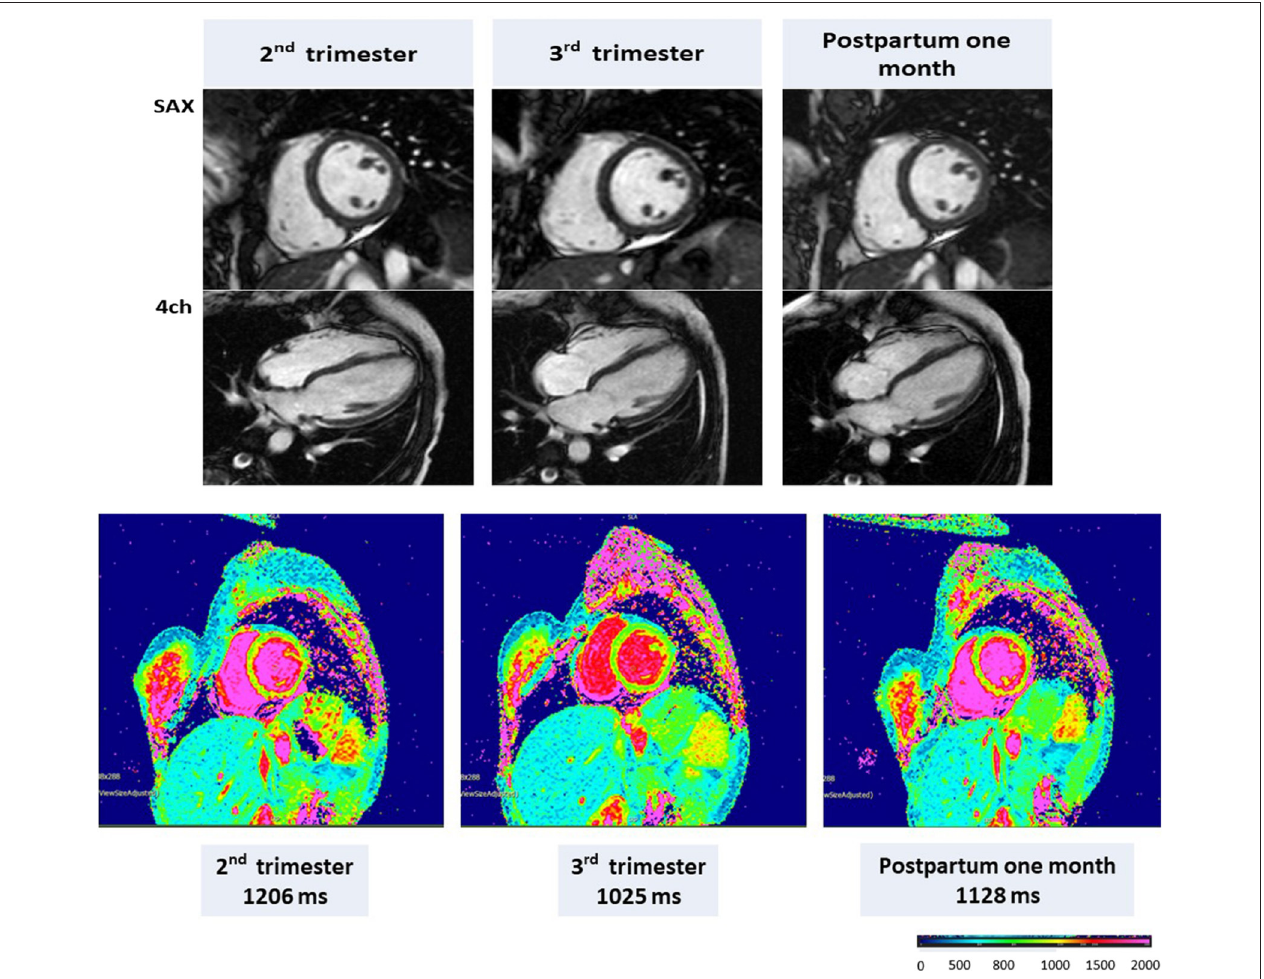
FIGURE 4 | CMR in a representative pregnant woman with end-diastolic volume (EDV), end-systolic volume (ESV), ejection fraction (EF), and left ventricular mass (LVM), respectively, of 132mL, 69mL, 48.0%, and 106g during the second trimester; 136mL, 60mL, 56%, and 95g during the third trimester; and 112mL, 57mL, 54%, and 76g at 1 month postpartum. Native T1 mapping (1.5T) using MOLLI with a native T1 of 1,206ms in the second trimester, 1,025ms in the third trimester, and 1,128ms at 1 month postpartum. Adapted from Nii et al.